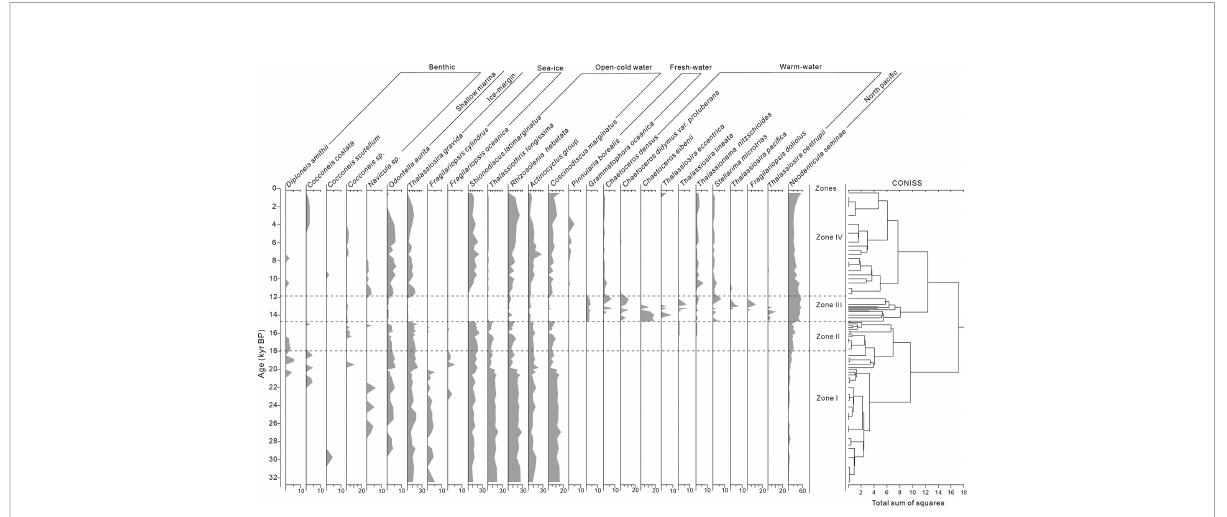
FIGURE 2 Relative abundance (%) of selected paleoenvironmental indicators in the diatom assemblages of core LV63-4-2. According to the results of stratigraphically-constrained cluster analysis, the diatom assemblages of core LV63-4-2 over the past 32 kyr can be divided into four zones (Zones I – IV). The plot was created using Tilia